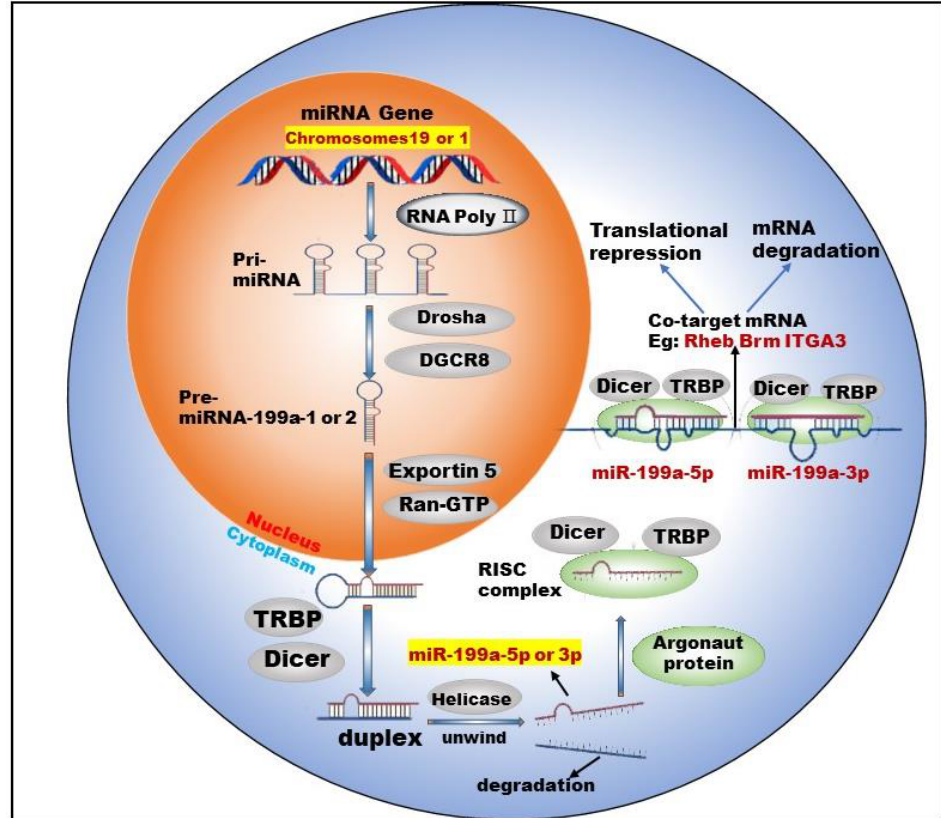
Figure 1. Biogenesis and co-targeting of miR-199a. The gene encoding miR-199a in the nucleus is processed into pri-miRNA catalyzed by RNA poly II. The pri-miRNA is then processed into a pre-miRNA by the shearing action of a complex composed of Drosha (a ribonuclease enzyme) and DGCR8 (Human Recombinant Protein (P01)). Pre-miRNA exits the nucleus into the cytoplasm with the help of Exportin 5 (Exporting protein 5) and Ran-GTP (Ras-like nuclear protein, GTPase). In the cytoplasm, Dicer (a ribonuclease enzyme) and TRBP (TAR-RNA binding protein) further process the pre-miRNA by excising the stem–loop structure at the end to form an unstable double-stranded RNA (dsRNA). DsRNA is unwound into single-stranded DNA by the action of Helicase, where one single strand is degraded and the other becomes a mature miRNA. The mature miRNA forms RISC (RNA-induced silencing complex) with TRBP, Argonaut protein and Dicer enzymes to perform biological functions.